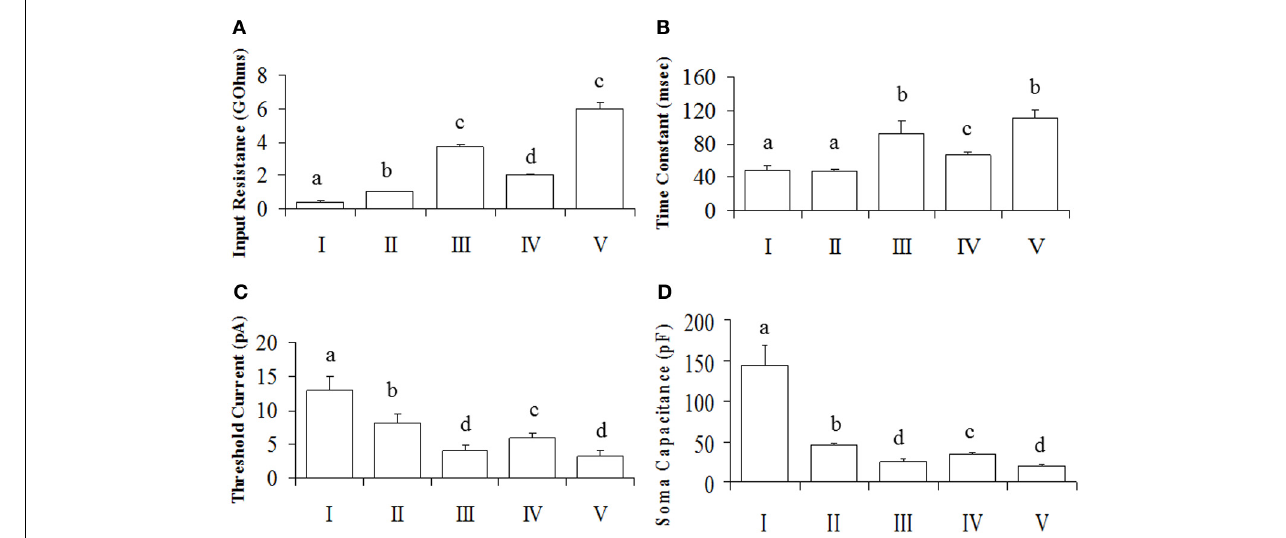
FIGURE 3 | Intrinsic membrane properties of POA neurons. Neurons were made up of connected ( N = 50) and unconnected ( N = 57) neurons to the OB. (A) The input resistance showing group differences. (B) The time constant, indicating differences between groups. (C) The threshold current